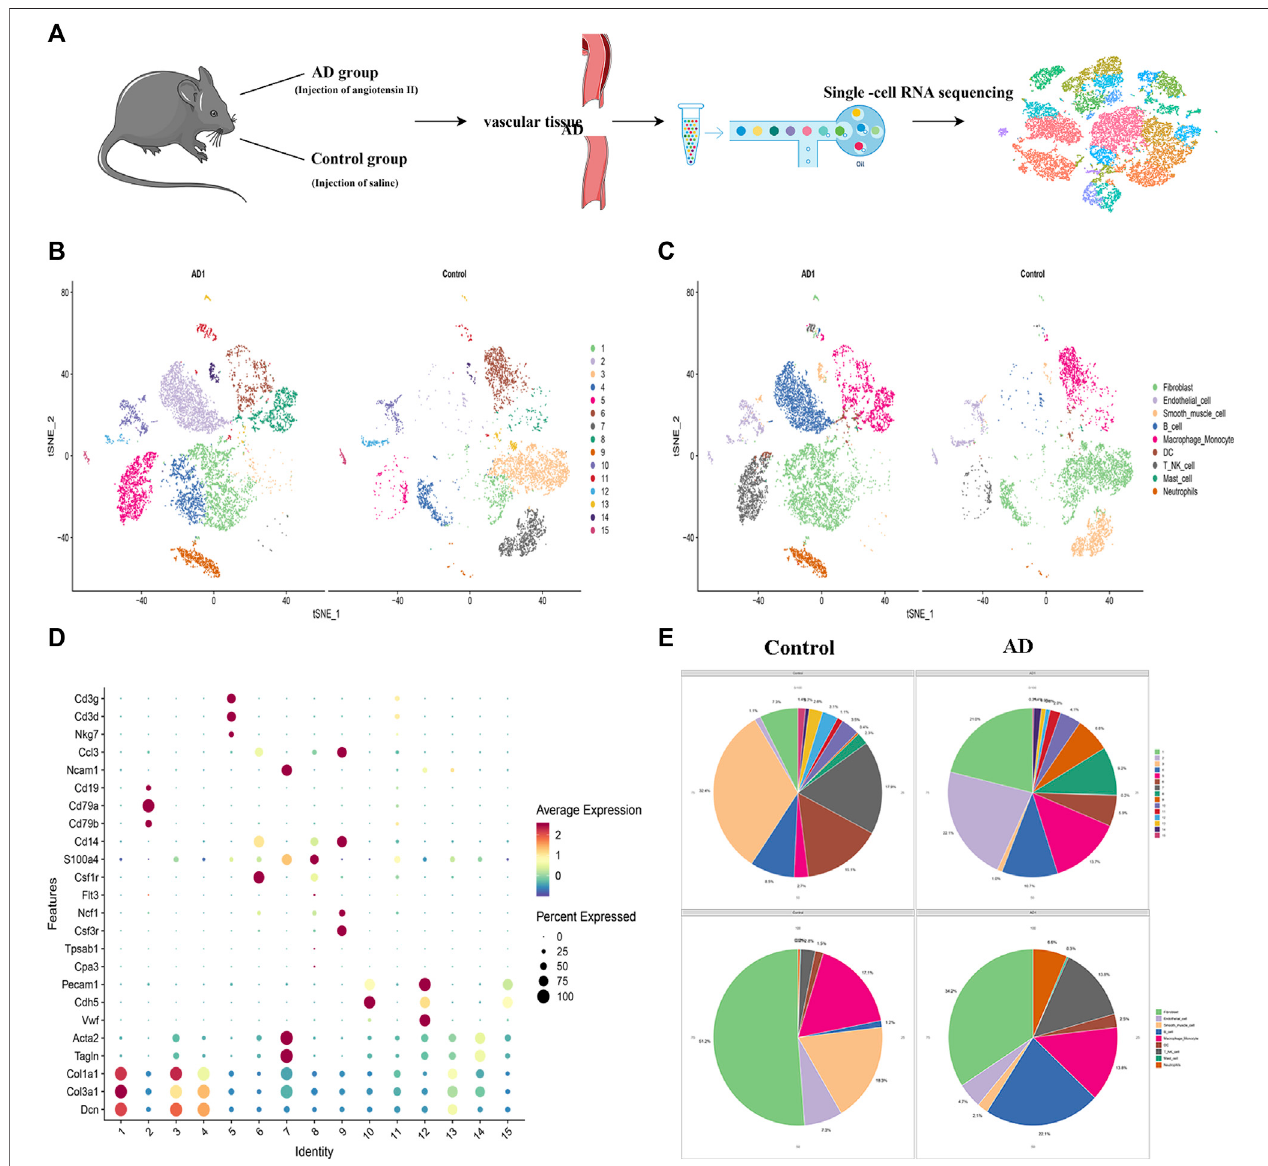
FIGURE 3 | Identi fi cation of cell clusters and types by single-cell RNA sequencing (scRNA-seq). (A) Schematic of the experimental design for single-cell RNA sequencing. (B) Distribution of cells in AD and control groups. (C) t-SNE plot demonstrated nine cell types. (D) the key marker genes in 15 clusters. (E) Pie chart of cell types and clusters.